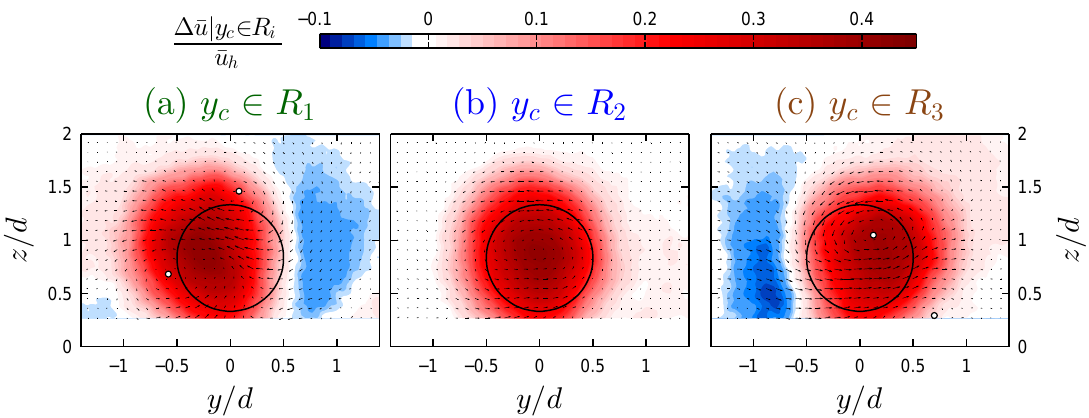
Figure 17. Contours of the conditionally-averaged normalized velocity deficit at x / d = 6 for: ( a ) y c ∈ R 1 , ( b ) y c ∈ R 2 and ( c ) y c ∈ R 3 . The vector field represents conditionally-averaged in-plane velocity components. Black circles indicate the frontal area of the wind turbine. White dots show the approximate position of the counter-rotating vortex pair (CVP).